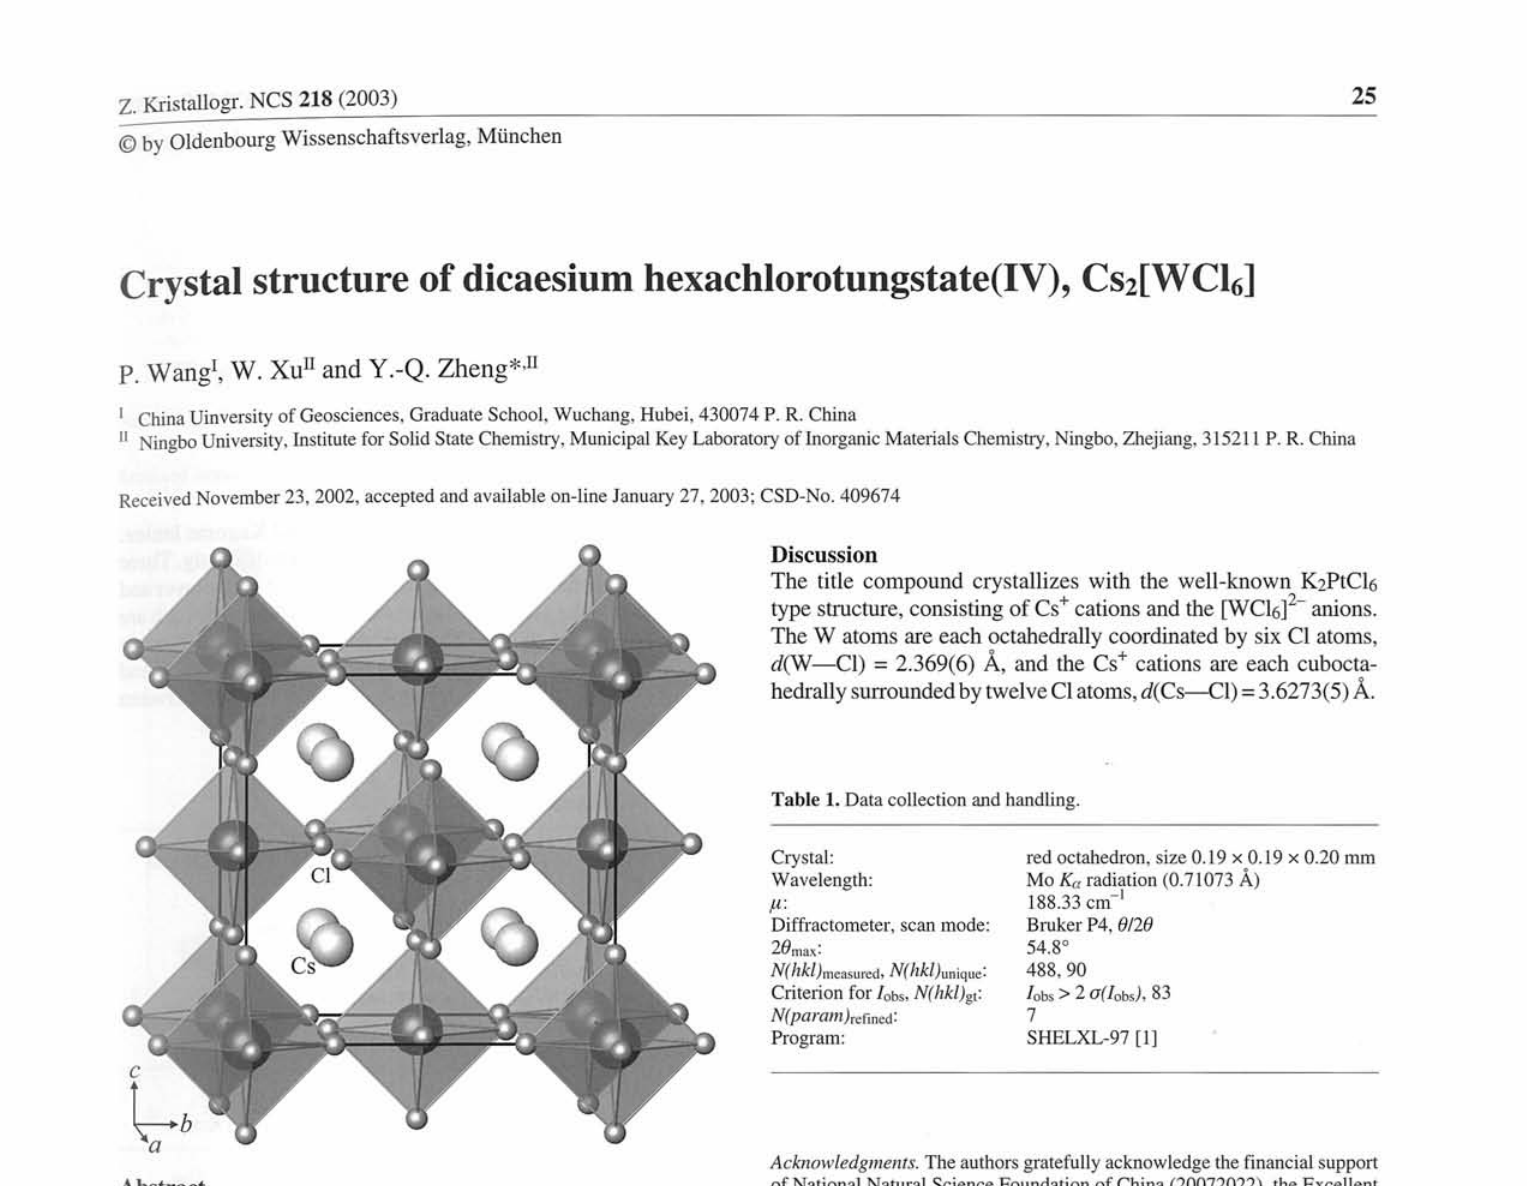
Source of material The reaction of CsCl (0.3 g, 1.78 mmol), WC1 4 (0.3 g, 0.92 mmol) and W powder (0.15 g, 0.82 mmol) in a sealed silica tube at a tem- perature gradient of 925 Κ/915 Κ for 1 week afforded a small amount of red octahedral crystals in the lower temperature zone.